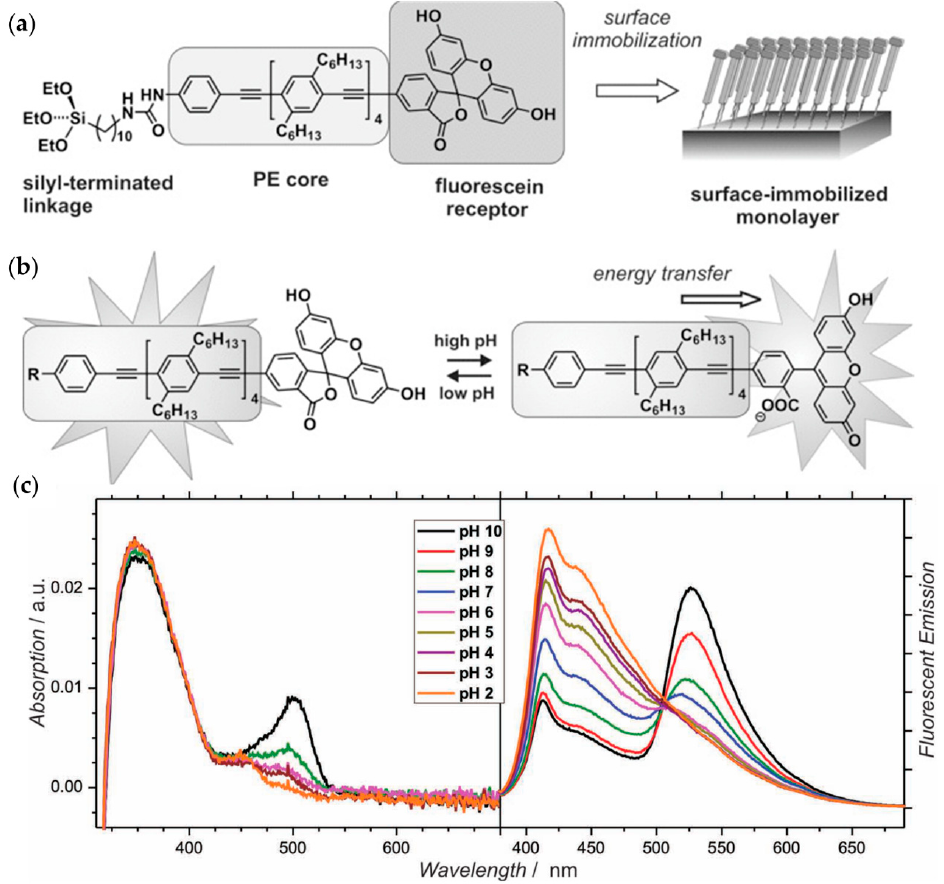
Figure 9. ( a ) Structure of the sensor and its assembly into a surface-immobilized monolayer. ( b ) The general principle of generating pH-dependent fluorescent response. ( c ) pH-dependent absorption (left) and fluorescence (right) spectra of monolayer fluorescein-oligomer film. Reprinted with permission from [86] . Copyright 2013 John Wiley and Sons.